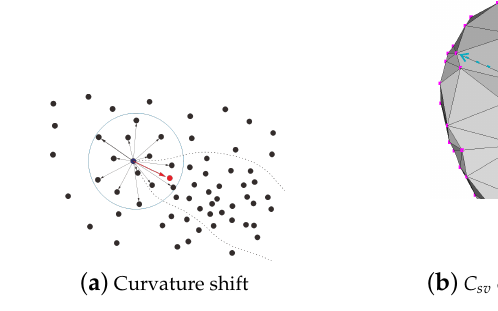
Figure 4. Curvature shift